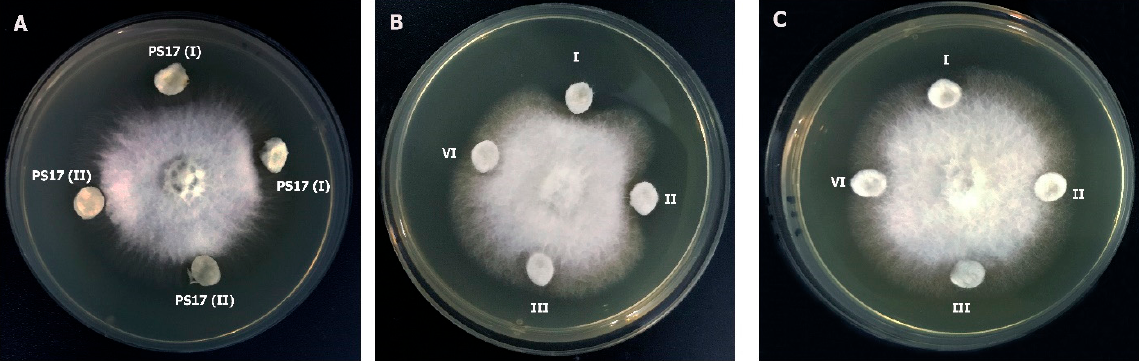
Figure 7. Antifungal activity of cell-free suspension ( A ) obtained from B. mojavensis PS17(I) and B. mojavensis PS17(II). Antifungal activity of lipopeptides extracted from ( B ) B. mojavensis PS17(I) and ( C ) B. mojavensis PS17(II) against phytopathogenic fungi Forl ZUM2407. Lipopeptide extracted with Diethyl ether (I), methanol/chloroform (II), toluene (III), and methanol (IV). Cotton wool discs amended with 50 µL of lipopeptide extracts diluted in (0.5%) DMSO were used for antifungal ability.